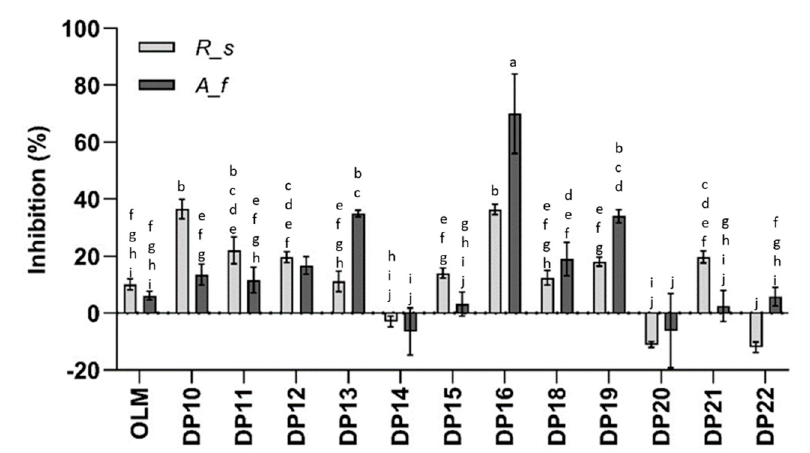
Figure 4. The comparison of the effects of DPs on the bioluminescence of A. fischeri (A_f) and on the inhibition of growth rates of R. subcapitata (R_s). Groups with the same letter were not significantly different (Tukey post hoc , p < 0.05).